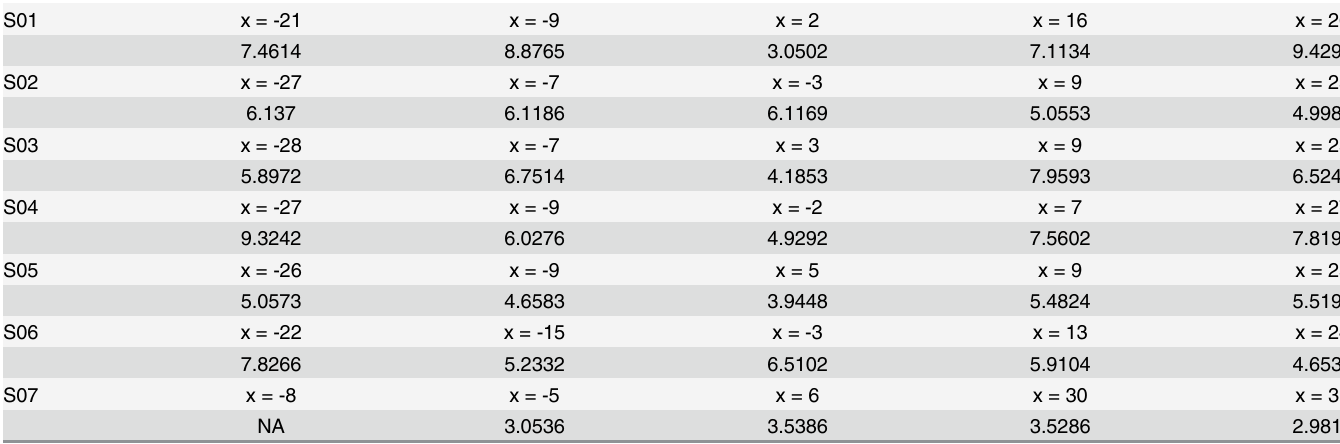
Table 1. Oculomotor Vermis Coordinates and Maximum T